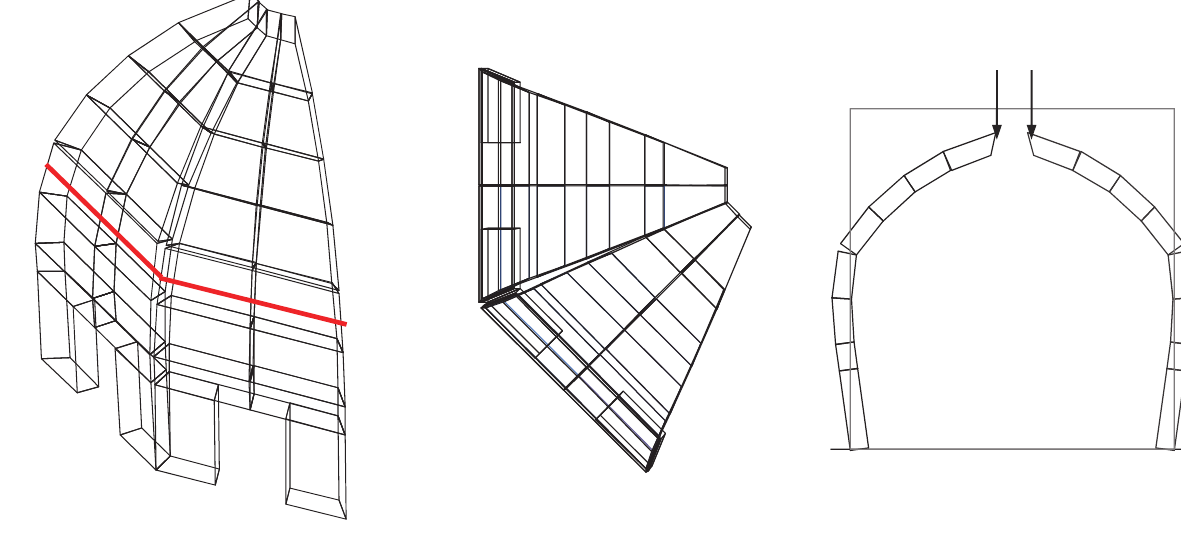
Figure 16: Collapse mechanism for case 8 (failure at ribs / Lf=2 / Nh=400 / sT=1.5 / multiplier α =7.624) Feature (d): drum